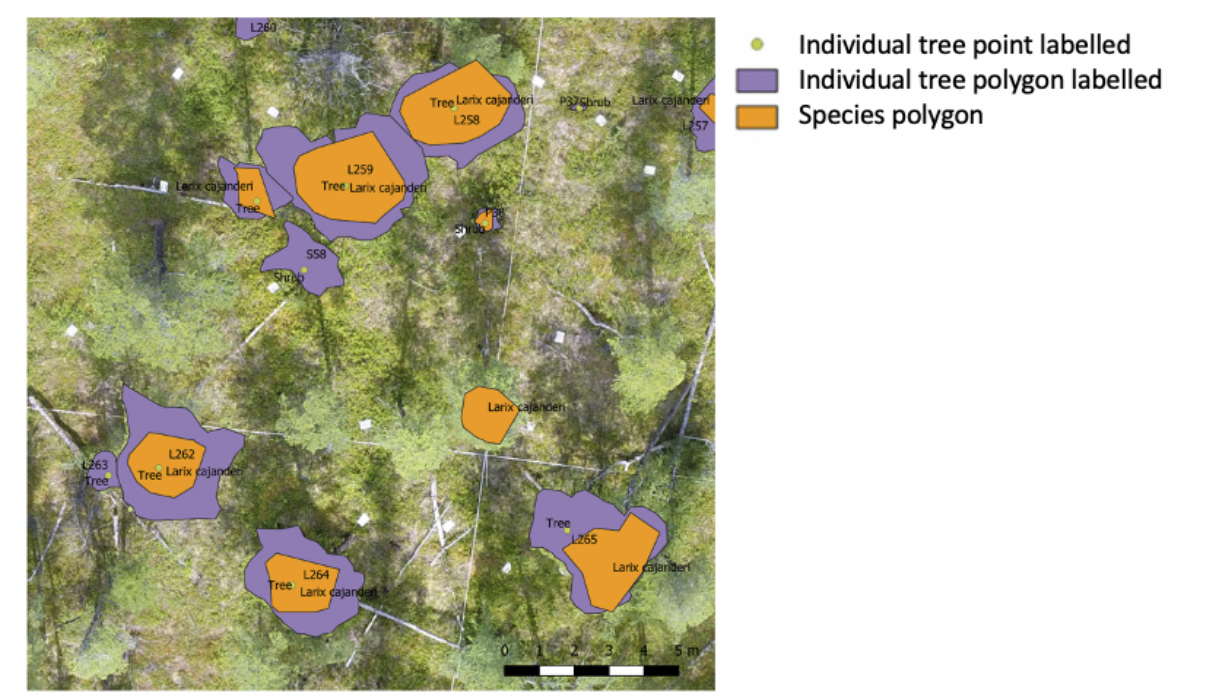
Figure 17. Overview of the three types of shapefiles included in the individually labeled trees dataset visualized on top of a red–green–blue (RGB) orthoimage.